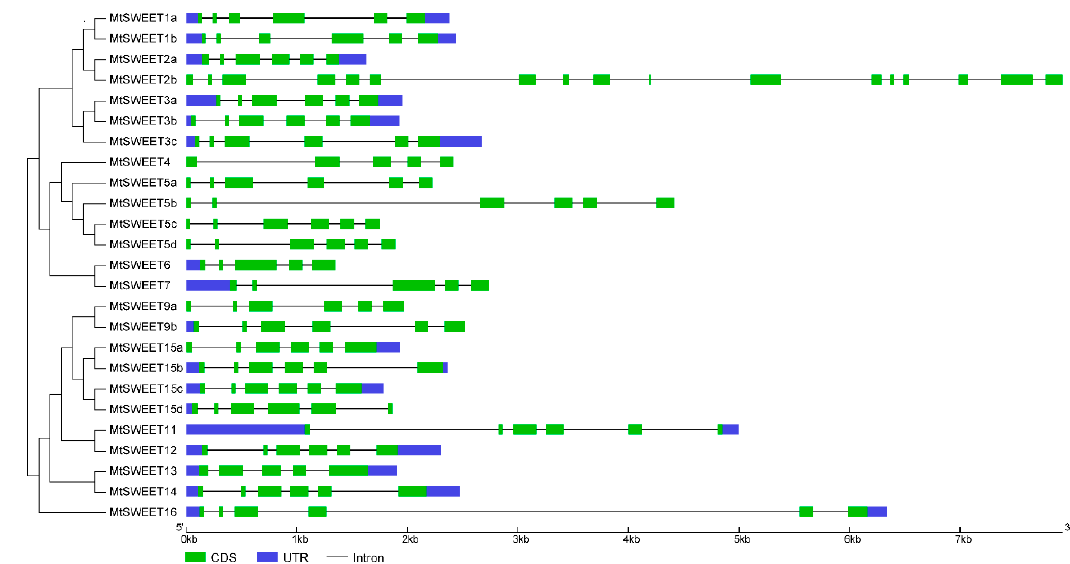
Figure 4. Gene structures of the MtSWEET genes according to their phylogenetic relationships. The blue boxes, green boxes, and black lines indicate UTRs (untranslated regions), CDSs, and introns, respectively.